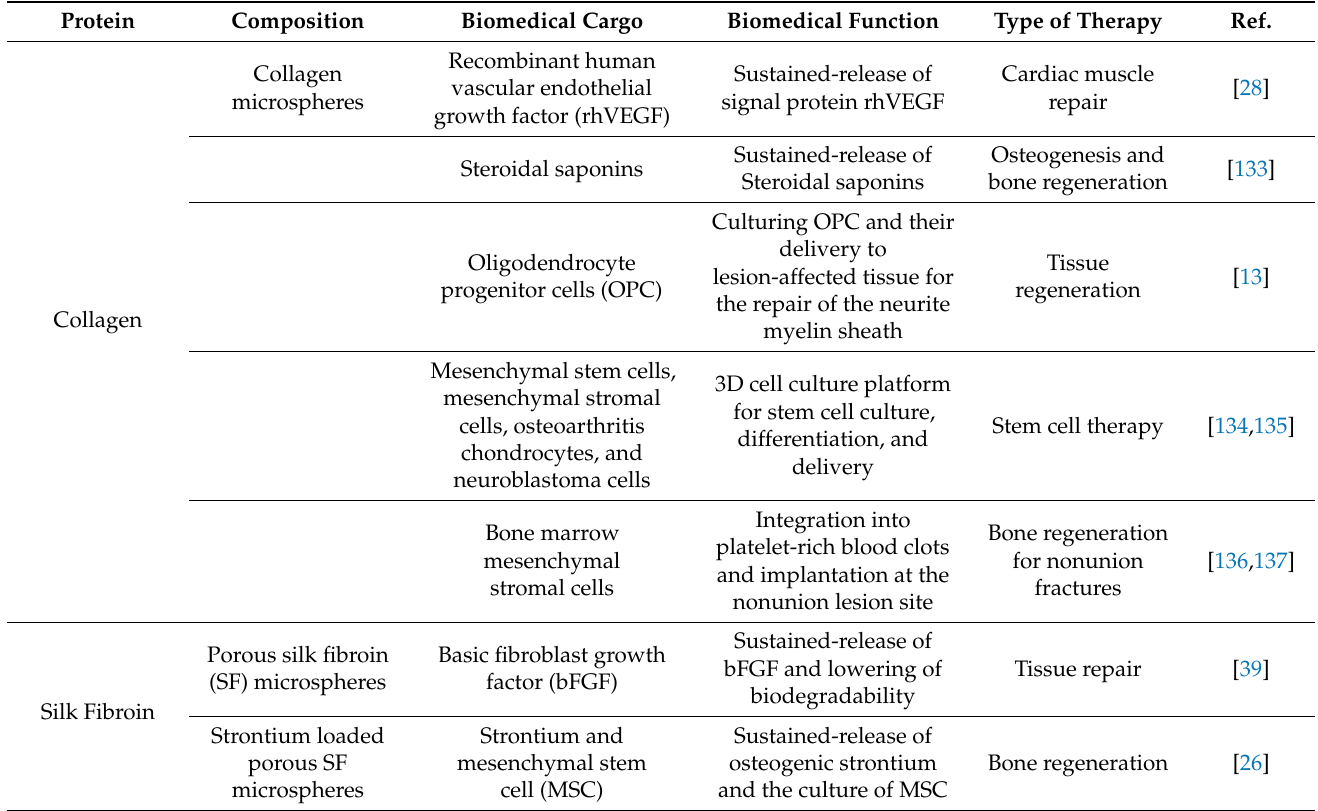
Table 6. Recent advances in the biomedical applications of porous protein